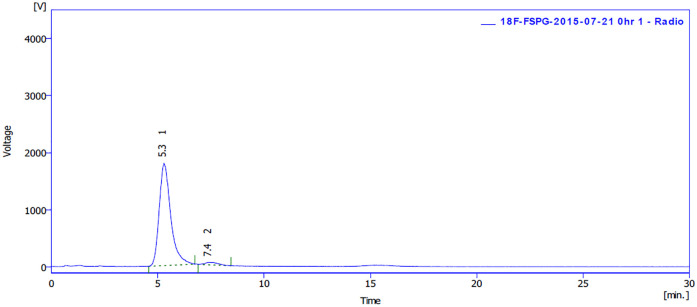
Chiral HPLC chromatogram of [18F]FSPG injection for clinical use.Using Chirex 3126 column: 30 mm × 4.6 mm; mobile phase: IPA:2 mM CuSO4 = 10:90; at 20°C.